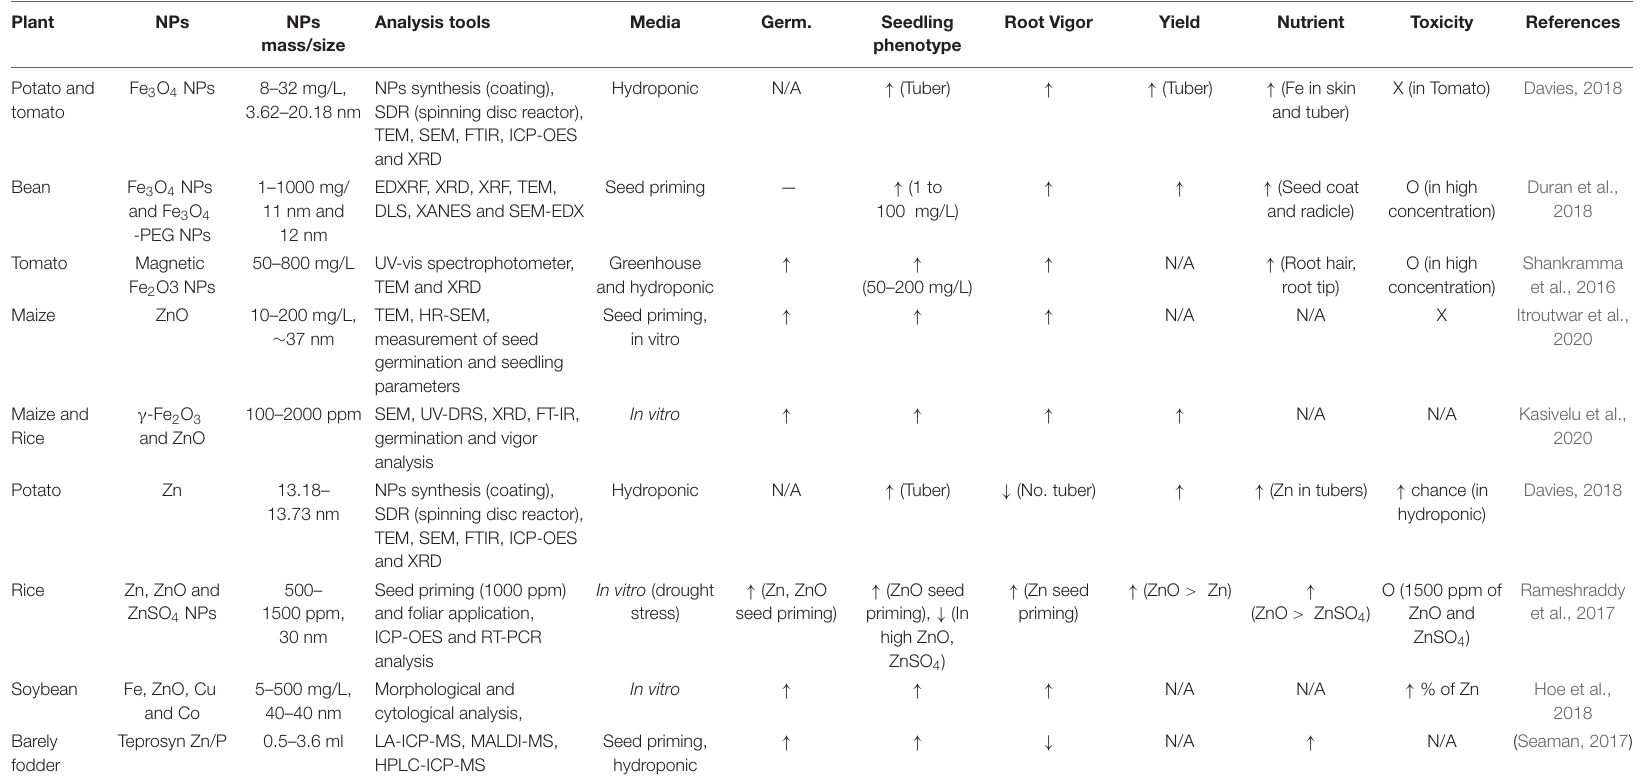
TABLE 2 | Micronutrient fortification relevant to vitamin B 12 deficiency in food crops using nanoparticles: Iron (Fe) and Zinc (Zn).